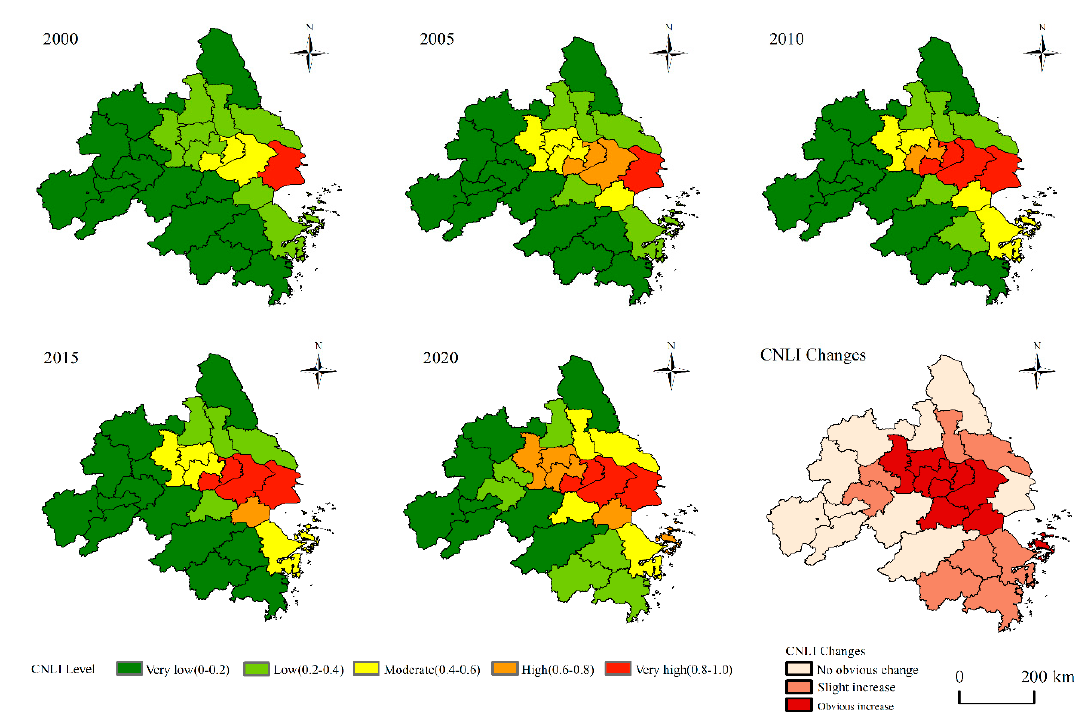
Figure 6. CNLI in prefecture-level cities and its